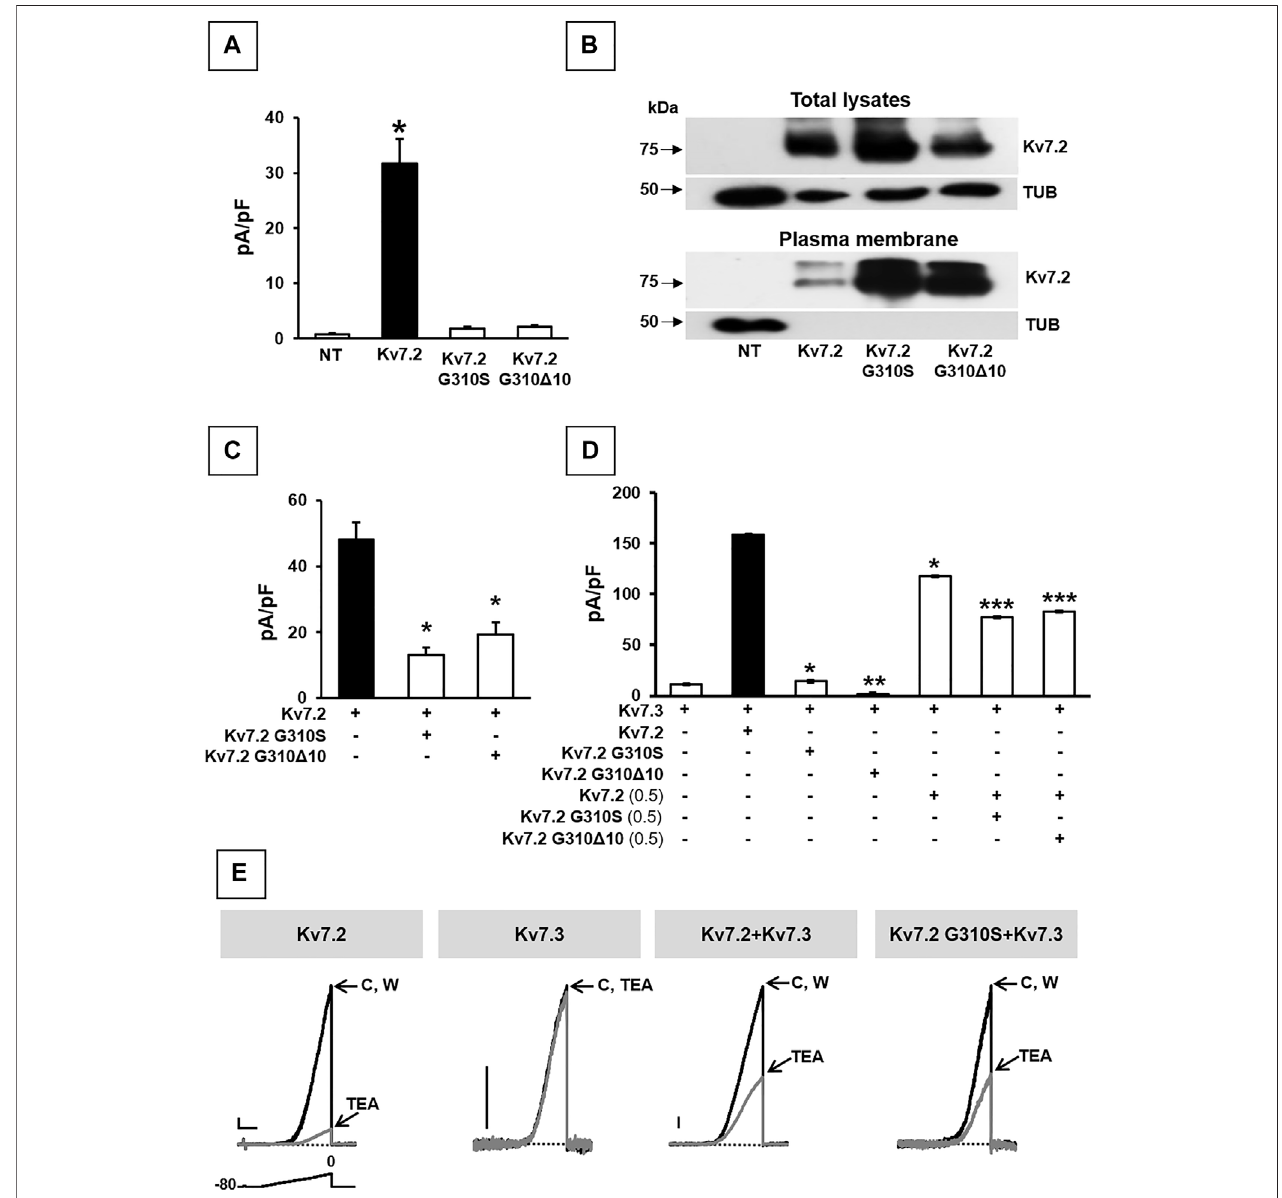
FIGURE 2 | Functional and biochemical characterization of Kv7.2 G310S and Kv7.2 G310 Δ 10 subunits. (A) Maximal current densities measured in non transfected cells (NT) or in cells expressing wild-type or mutant Kv7.2 subunits, as indicated. * = p < 0.05 versus NT cells. (B) Western blot analysis of proteins from total lysates (upper panels) or biotinylated plasma membrane fractions (lower panels) from CHO cells transfected with the indicated constructs. Higher and lower blots were probed with anti- Kv7.2oranti- α -tubulinantibodies,asindicated.Numbersontheleftcorrespondtothemolecularmassesoftheproteinmarkers.ODKv7.2TOT/ODTUBratioswere1.00± 0.20,1.54±0.19,or0.66±0.25;n=4; p > 0.05amongeachother;ODKv7.2BIOT/ODTUBratioswere1.00±0.50,5.2±1.50,or3.33±0.45inKv7.2-,Kv7.2p.G310S-, orKv7.2p.G310 Δ 10-transfected cells,respectively;n=4; p < 0.05versusKv7.2. (C,D) Quanti fi cationofmaximalcurrentsmeasuredinCHOcellsexpressingeitherKv7.2 variantwithKv7.2 (C) and/orKv7.3 (D) subunits,asindicated.*= p < 0.05versustheblackbarineachpanel;**= p < 0.05versusKv7.3;***= p < 0.05Kv7.2+Kv7.3(0.5: 1). (E) Representative current traces recorded upon application of the ramp protocol (shown below the fi rst traces) on CHO cells expressing the indicated constructs in control solution (C) , after 2-min 3 mM TEA perfusion, or upon drug washout (W). Current scale: 100 pA; time scale: 1